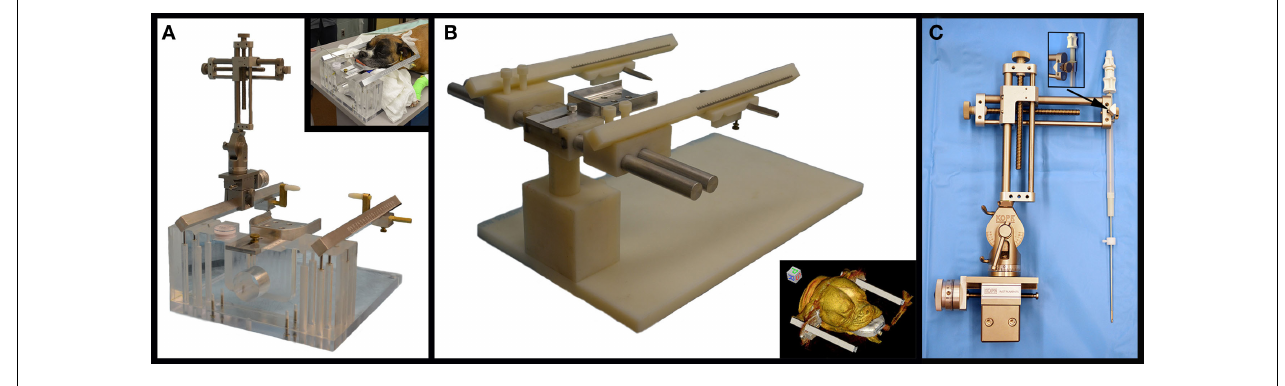
three-dimensional reconstructed CT image of canine patient in the frame (inset). (C) Micromanipulator with biopsy needle and guide tube assembly mounted to the lateral arm using a knurled thumb screw coupler